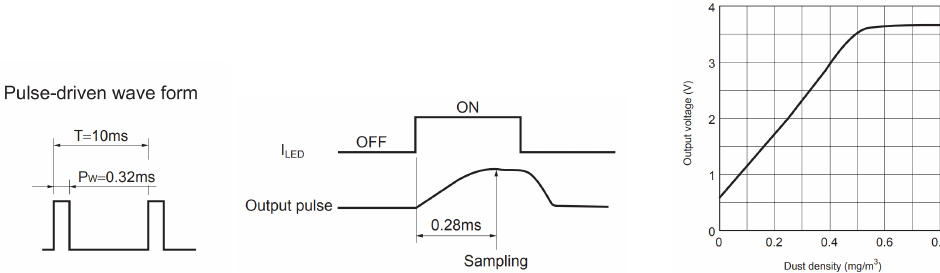
Figure 3. Manufacturer’s recommended driving signals timings and calibration curve taken with permission from the Data sheet [15]. ( Left ) the control TTL signal on pin 3-LED, ( center ) predicted output pulse shape and moment of the recommended voltage sampling. The sampled voltage should be correlated to the dust density as shown in the given calibration curve ( right